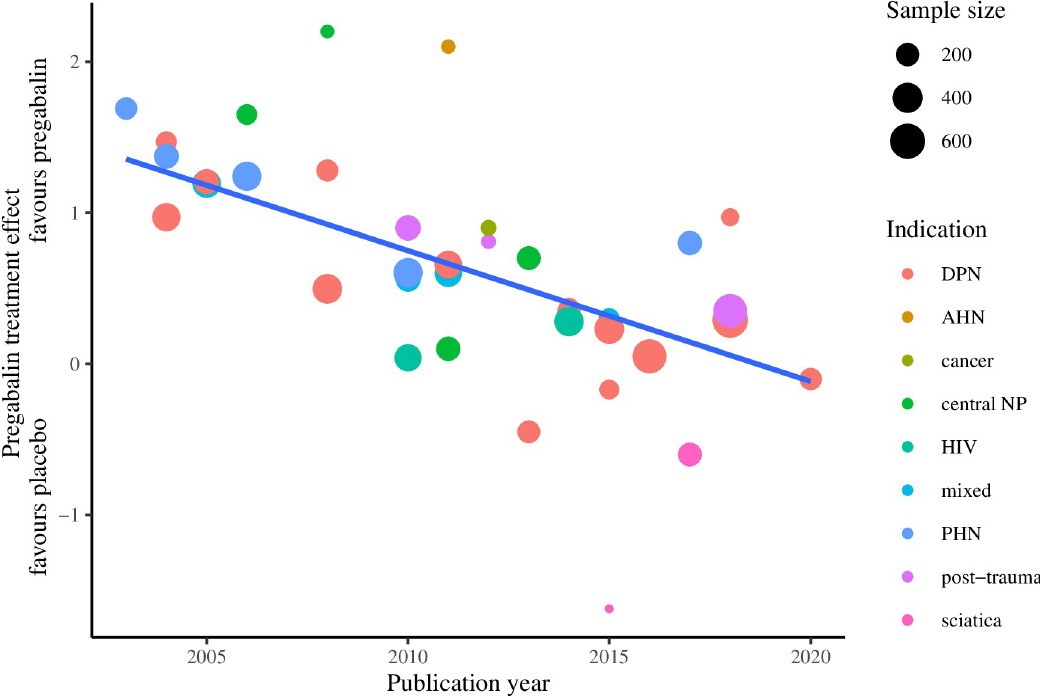
Fig 4. Treatment effect of pregabalin over publication year � overall. � Derived from unadjusted meta-regression models. Subgroups with two or fewer studies were not evaluated.